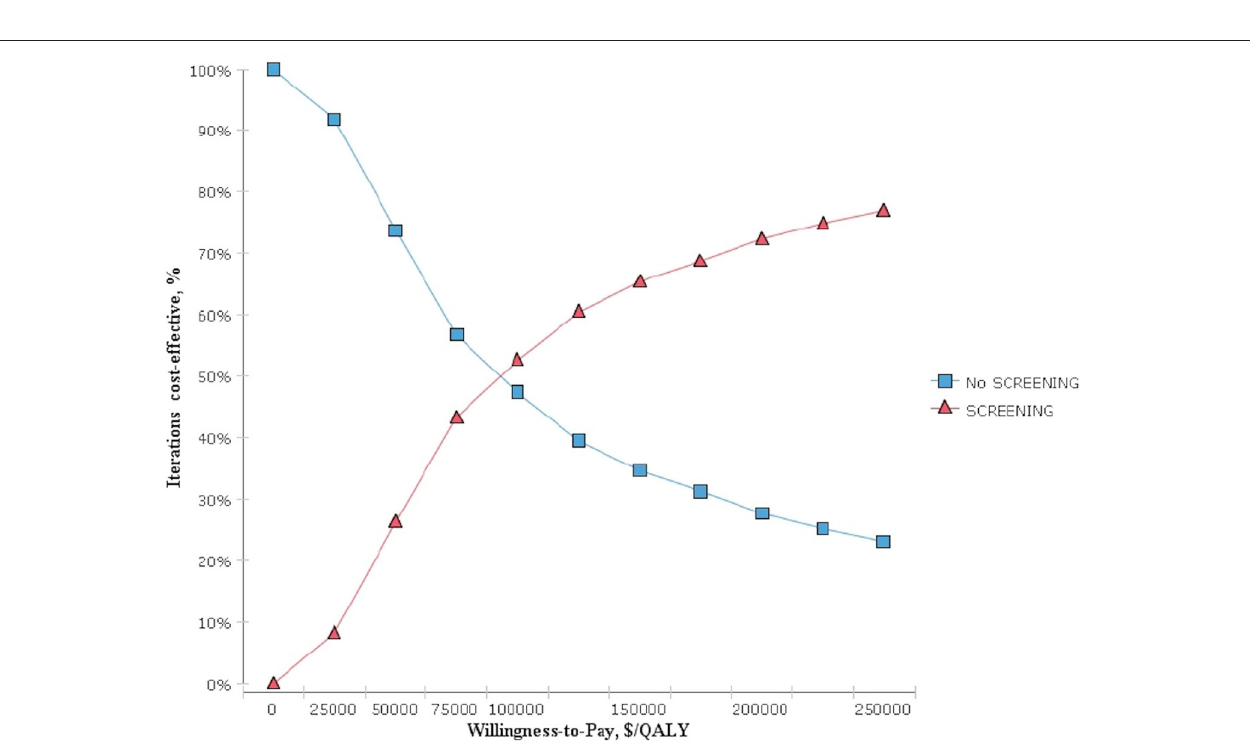
FIGURE 3 | Incremental cost-effectiveness scatter plot for screening group vs. non-screening group based on Monte Carlo simulation.